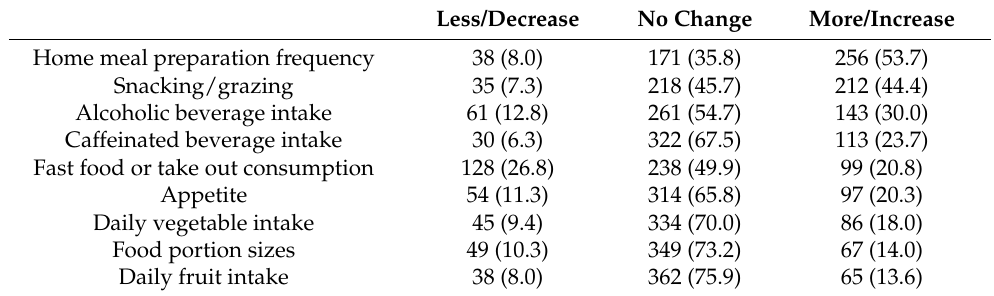
Table 2. Eating pattern changes during the height of the COVID-19 pandemic among RDNs. n (%).